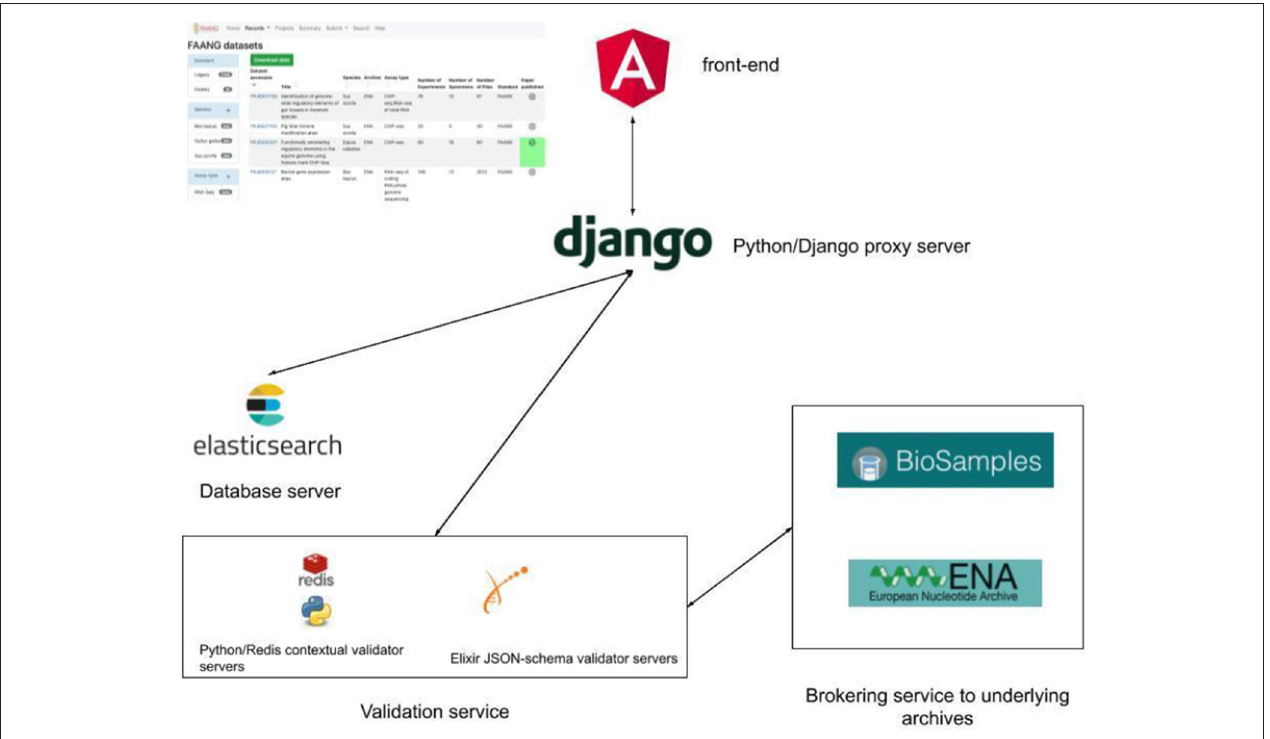
FIGURE 1 | FAANG Data Portal architecture with local Elasticsearch metadata database, python, and JSON-schema contextual validation and brokering of validated data to underlying public archives.